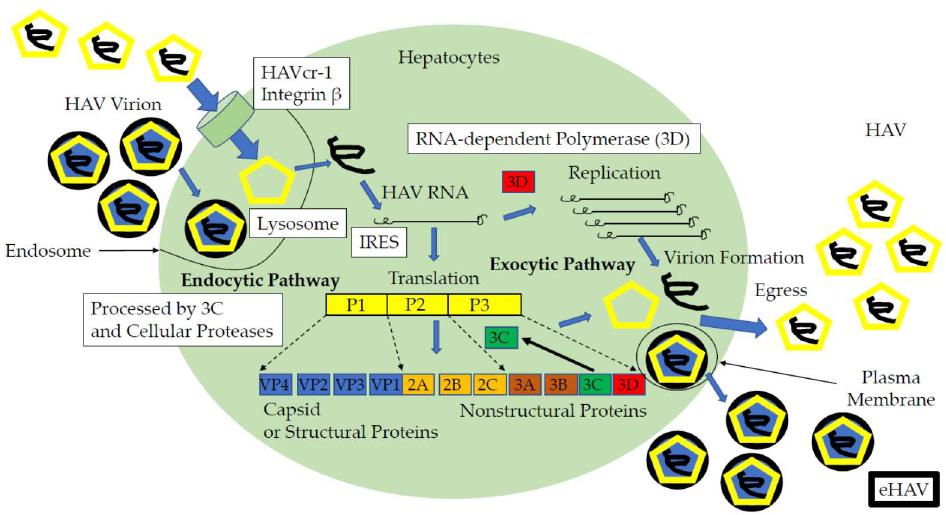
Figure 1. Life cycle of the hepatitis A virus and candidates of anti-HAV drug targets (open squares). HAVcr-1, hepatitis A virus cellular receptor 1; IRES, internal ribosomal entry site; HAV, naked HAV; eHAV, quasi-enveloped HAV; bold black circle, envelope; yellow pentagon, viral capsid